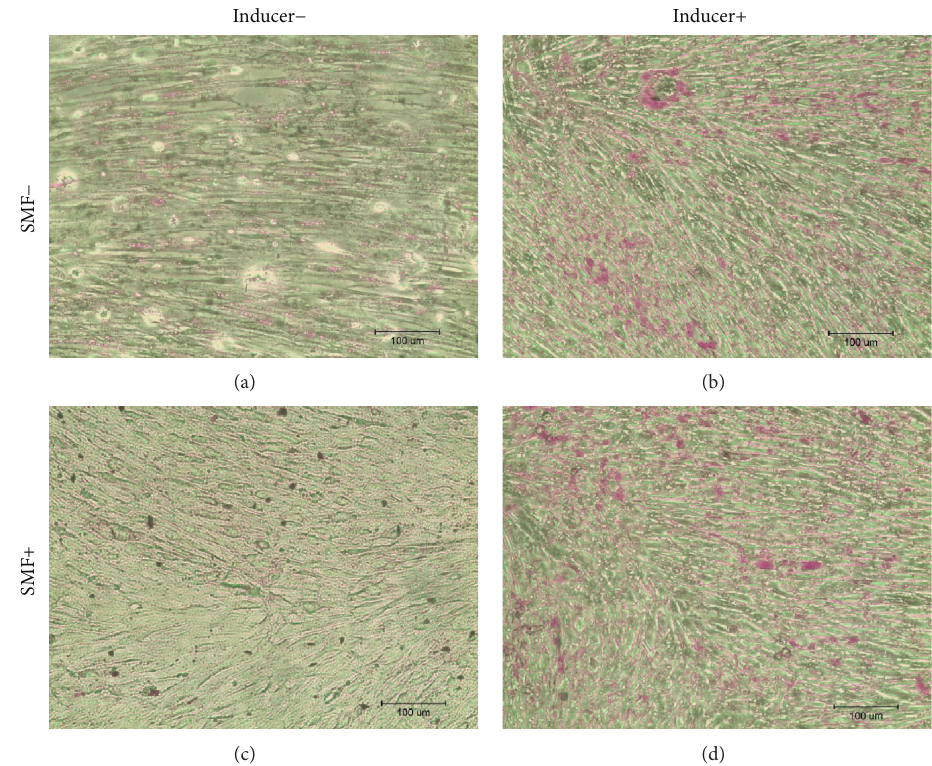
Figure 4: Oil Red O staining results showed the intracellular lipid droplets stained in red after adipogenesis induction. No significant differences could be observed between SMF-exposed and sham-exposed DPCs after adipogenesis